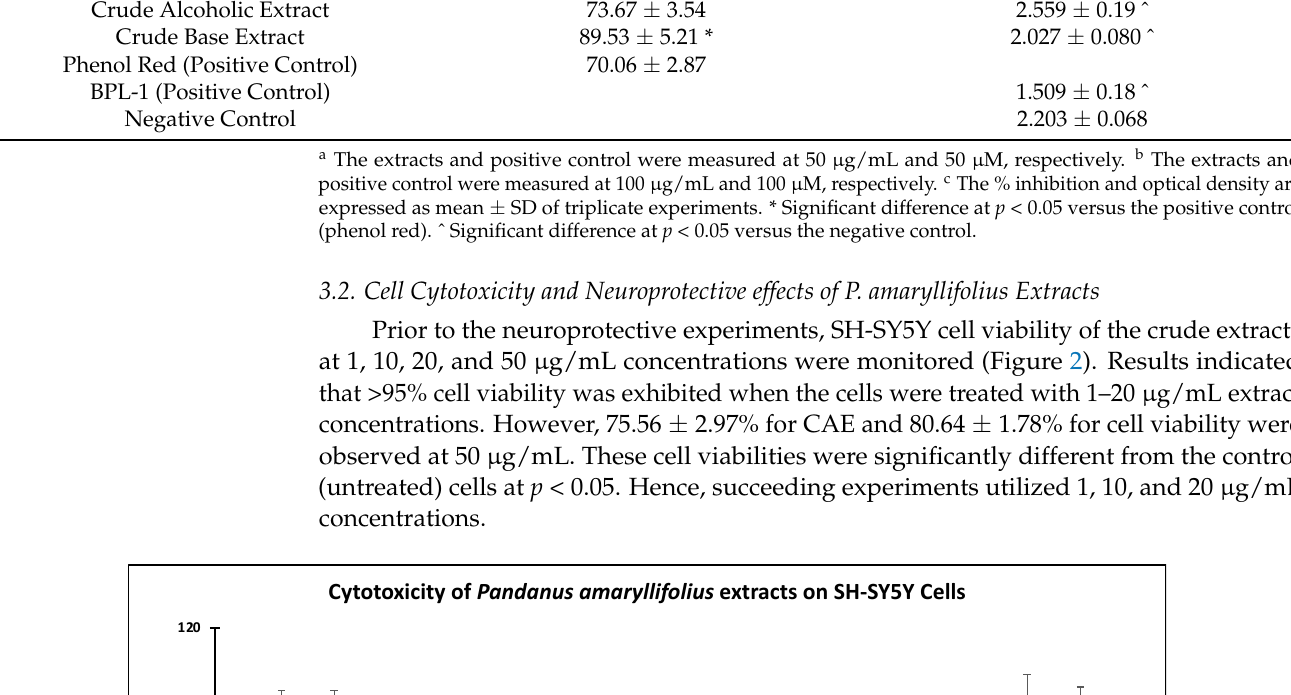
Table 1. Measurement of the Inhibition of Amyloid- β Aggregation using the Thioflavin T (ThT) Assay and the Inhibition of Amyloid- β Oligomerization using the Multimer Detection System (MDS) Assay. ThT Assay a (% Inhibition) c